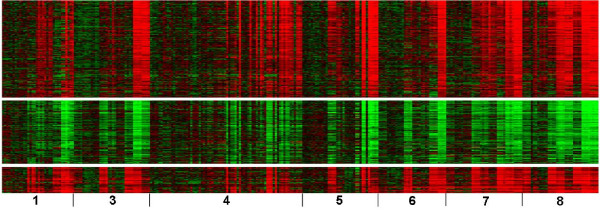
Heat maps of three biclusters containing genes discerning isomers or depicting an early response to the toxic exposure. (A) 175 co-expressed genes are up-regulated (top); (B) 114 co-expressed genes are down-regulated (middle). (C) 47 co-expressed were up-regulated (bottom). The samples are ordered the same as in Figure 2.